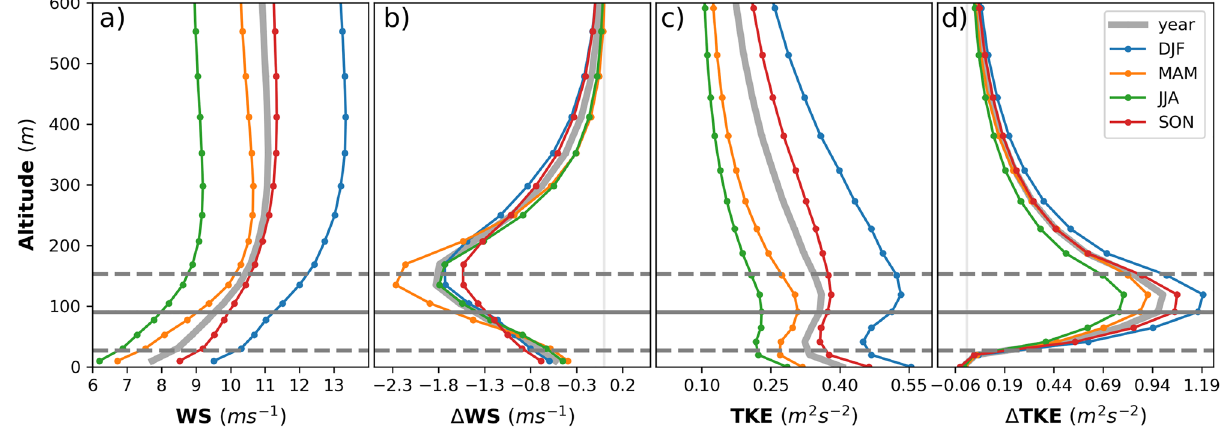
Figure 2. Mean vertical profiles of the CCLM for ( a ) wind speed and ( c ) turbulent kinetic energy and differences between the CCLM_WF and CCLM in vertical profiles of the ( b ) wind speed and ( d ) turbulent kinetic energy over the wind farm areas in 2008–2017 for all wind directions (0–360°). Solid circles indicate the model’s main levels ( a ) or half levels ( b ). The solid gray line indicates the hub height (90 m) of the turbine, whereas dotted gray lines indicate the lower (27 m) and upper (153 m) tips of the